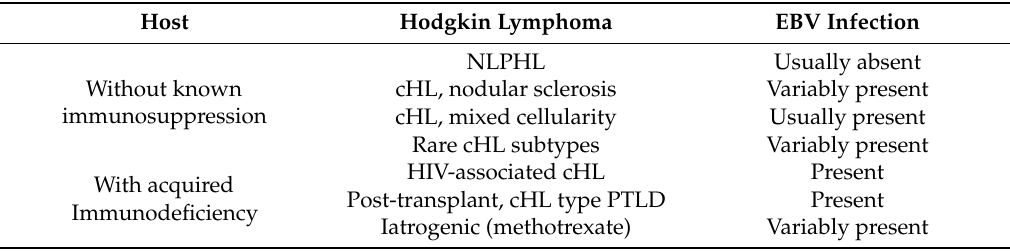
Table 1. EBV infection in Hodgkin lymphoma according to the immunocompetence status of the host. Host Hodgkin Lymphoma EBV Infection NLPHL Usually absent Without known cHL, nodular sclerosis Variably present immunosuppression cHL, mixed cellularity Usually present Rare cHL subtypes Variably present HIV-associated cHL Present With acquired Post-transplant, cHL type PTLD Present Immunodeficiency Iatrogenic (methotrexate) Variably